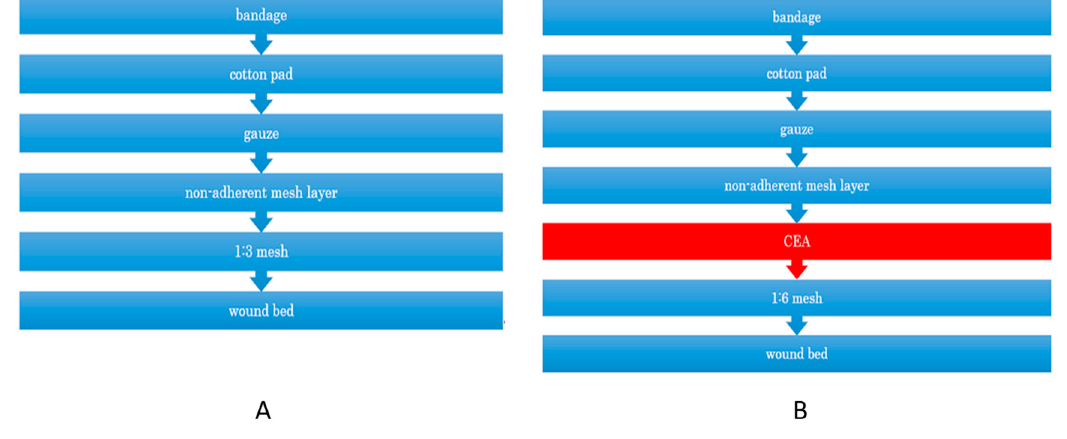
Figure 1. Schematic cross-section of 1:3 mesh without CEA (JACE ® ), ( A ) and 1:6 mesh plus CEA (JACE ® ) coverage, ( B ).